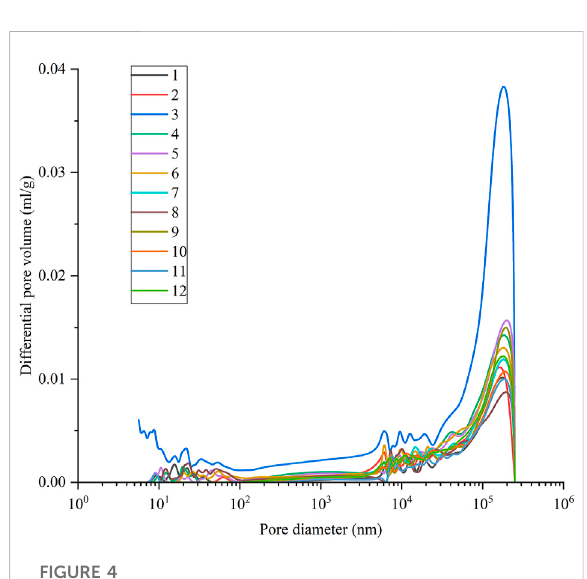
FIGURE 4 Pore size distributions (PSDs) of shales estimated from mercury intrusion porosimetry (MIP)